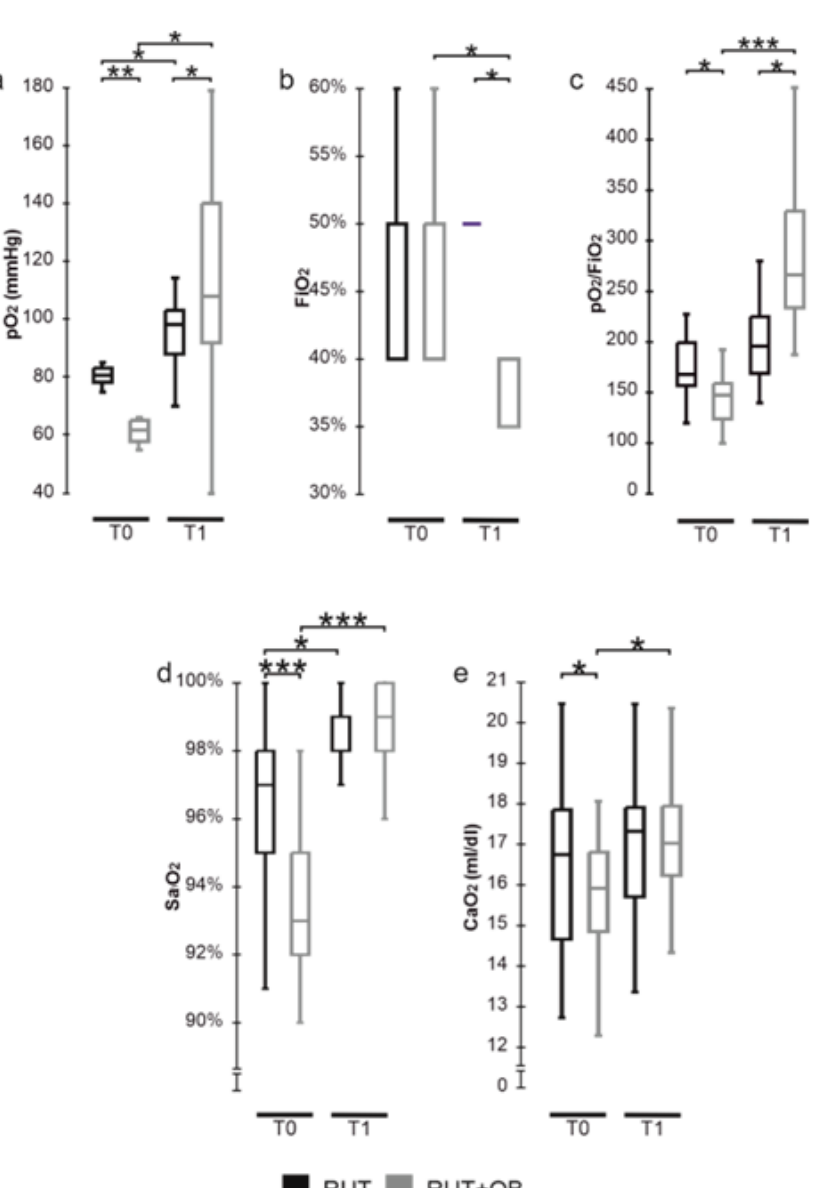
Figure 3. Distribution of blood oxygenation variables between groups at different time points: ( a ) pO 2 (mmHg); ( b ) FiO 2 ; ( c ) pO 2 /FiO 2 ; ( d ) SaO 2 ; ( e ) CaO 2 (mL/dL). Data are represented as boxplots showing median and IQR (25–75%). *: p ≤ 0.05; **: p ≤ 0.001; *** p < 0.0001.